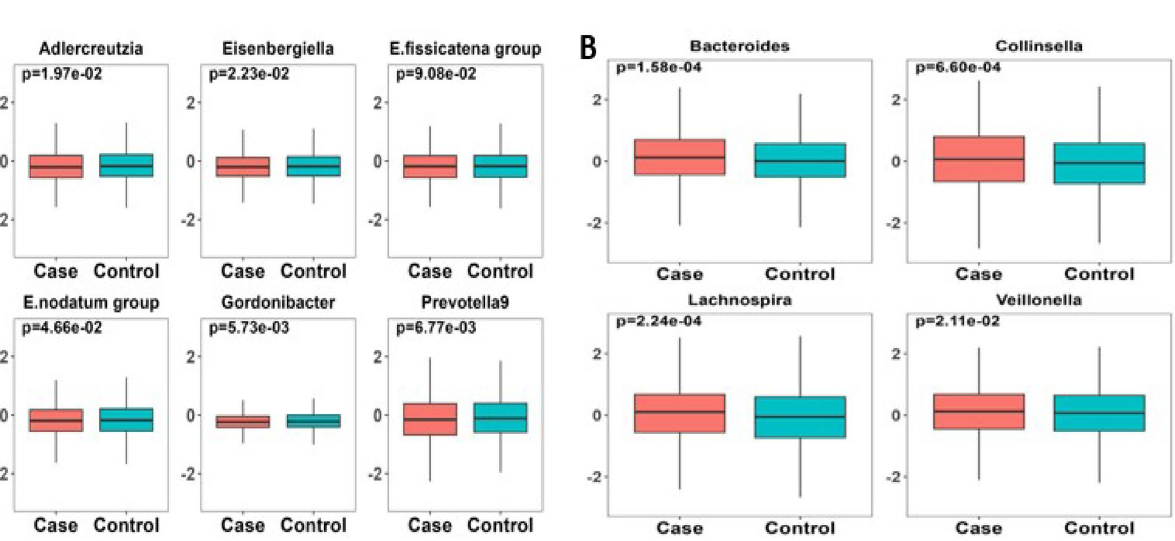
Figure 3. Normalized PRSs for ten significant genera between AD cases and controls in the discovery sample. ( A ) PRSs for six genera were relatively lower in AD cases than controls ( p < 0.05), suggesting they might be a protective factor for AD. ( B) PRSs for four genera were relatively higher in AD cases vs. controls ( p < 0.05), suggesting they were likely be a risk factor for AD. Wilcoxon Rank Sum test was applied to generate p values. X-axis: Diagnosis (AD cases/controls). Y-axis: z-score normalized PRSs for each of the ten significant